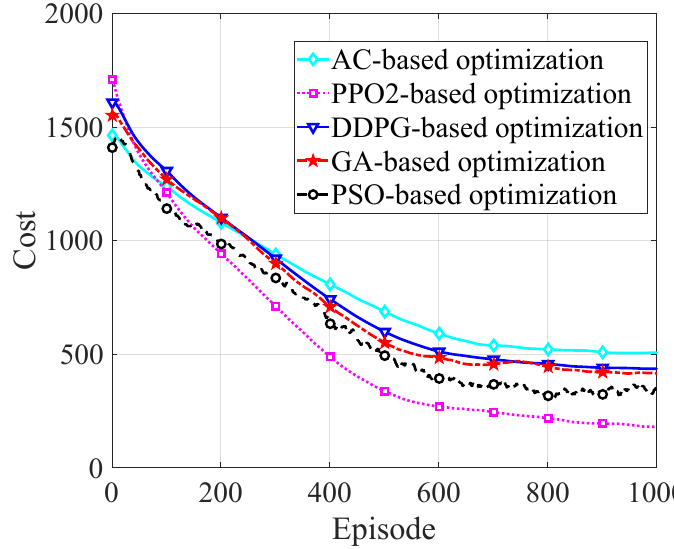
Figure 7. Comparison of the profits of different